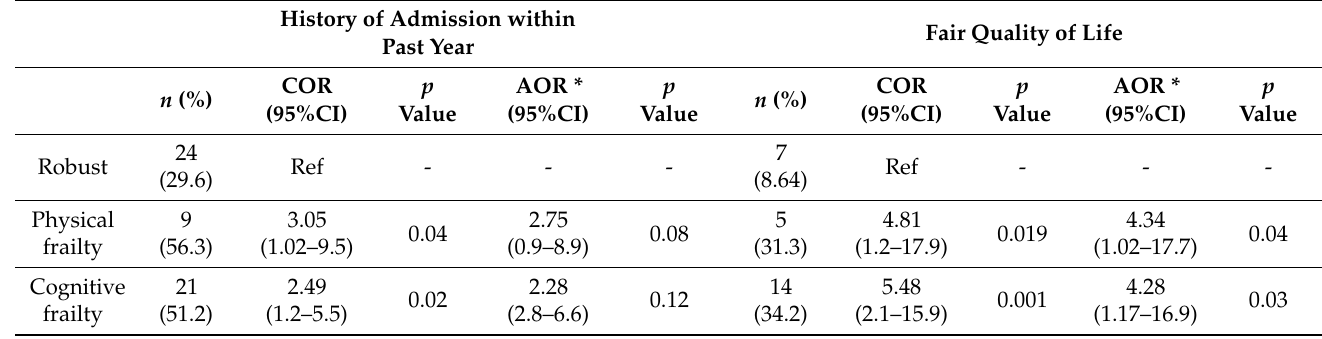
Table 3. Comparison of adverse outcomes among participants, depending on frailty and cognitive